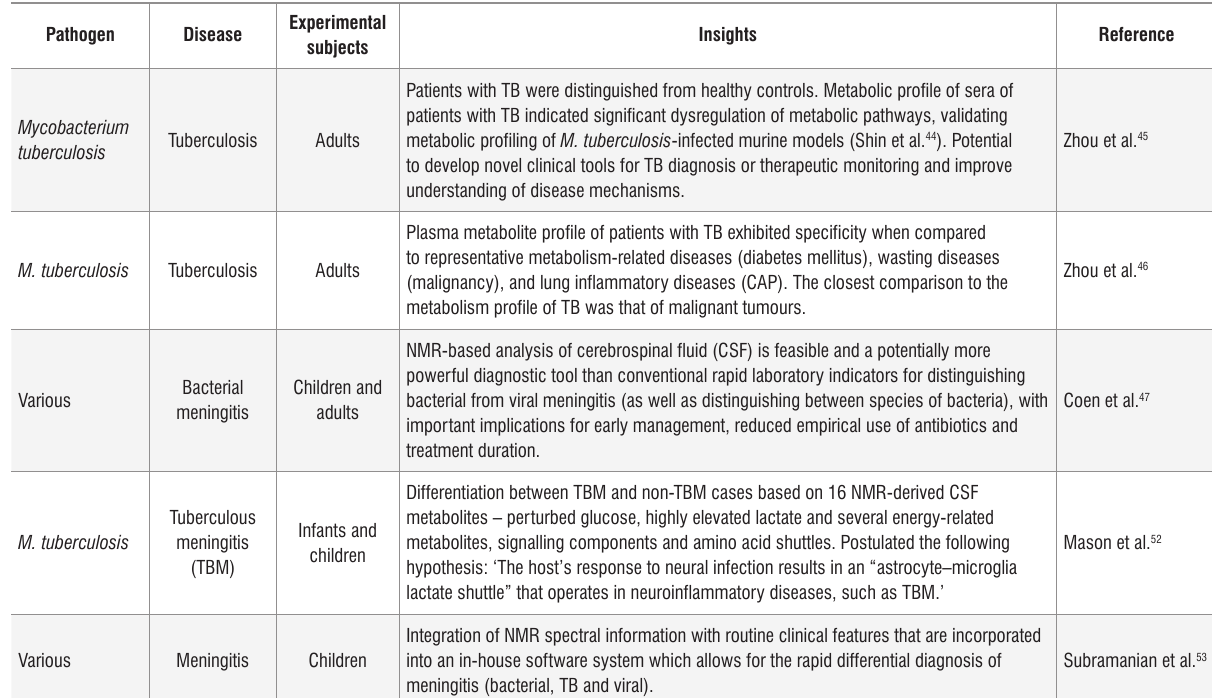
Table 1: Insights offered by nuclear magnetic resonance (NMR)-based metabolomics studies specific to tuberculosis (TB) and meningitis Experimental Pathogen Disease subjects